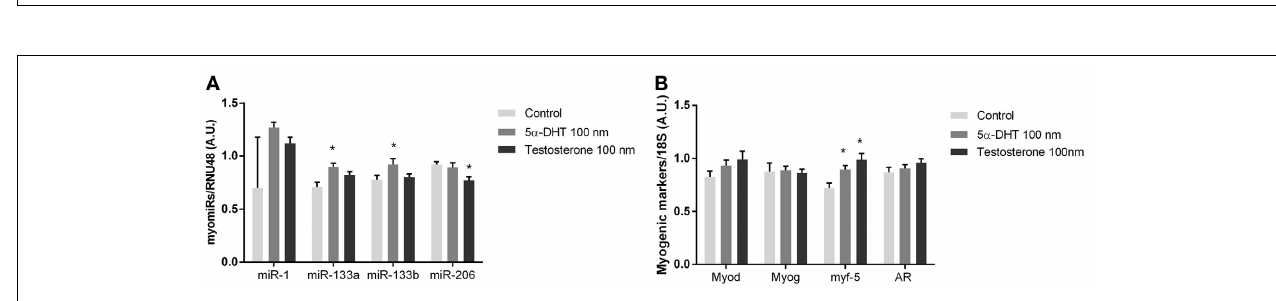
mir-206 were not significantly different between castrated and sham operated mice (A) . Whereas the expression of Myog was upregulated ( ∗ P < 0 . 05) in castrated mice, no regulation of Myod, Myf-5, or Ar was detected ( P > 0 . 05) (B) . Data are mean ± SEM.